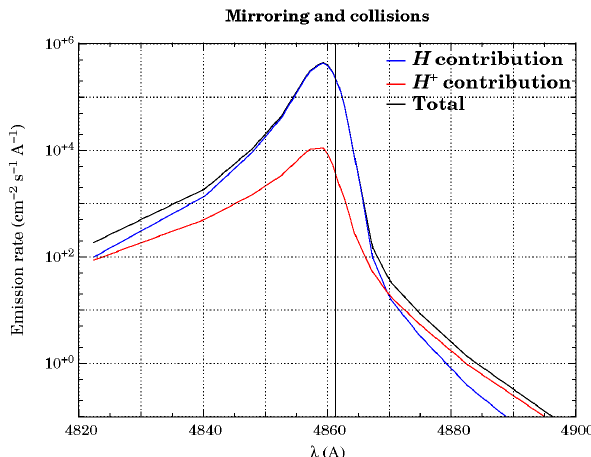
Fig. 8. H β emission rates including angular redistributions of mag- netic and collisional origins. In blue the hydrogen contribution to the emission is plotted, and in red the proton contribution.